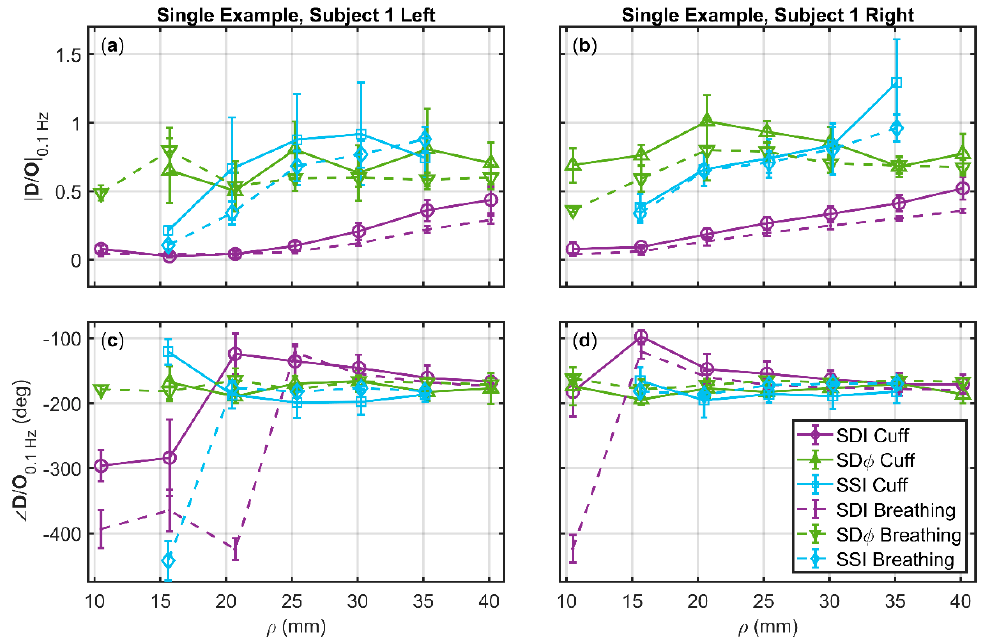
Figure 4. Amplitude ratio ( a , b ) and phase difference ( c , d ) of oxyhemoglobin ( O ) and deoxyhemoglobin ( D ) phasors at 0.1 Hz as a function of source-detector separation ( ρ ). Data were measured on subject 1 on the left sides ( a,c ) and on the right side ( b,d ) of the subject’s forehead. Shown for the cyclic thigh cuff inflation (solid lines) and paced breathing (dashed lines) protocols, and three analysis methods: single-distance intensity (SDI, purple), single-distance phase (SD ϕ , green), and single-slope intensity (SSI, cyan). SSI measurements analyzed with two sources spaced by 10 mm, plotted such that ρ is the average of the source-detector distances of the two sources. Note: Error bars represent the standard deviation of all analyzed pixels that show significant coherence in the wavelet transfer function scalogram.